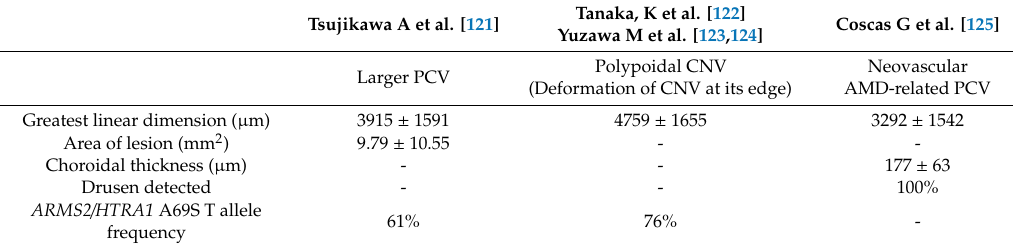
Typical PCV PCV in the narrow and strict sense (Abnormalities of the choroidal vessels)